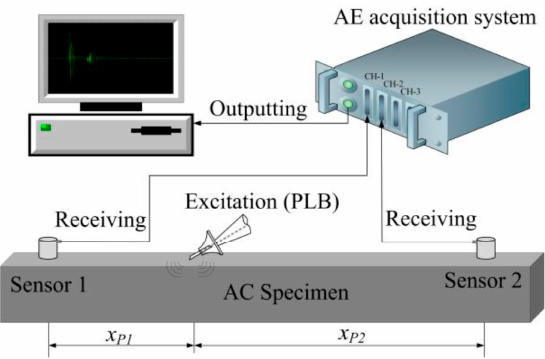
Figure 4. Measurement of the wave velocity by the PLB method.